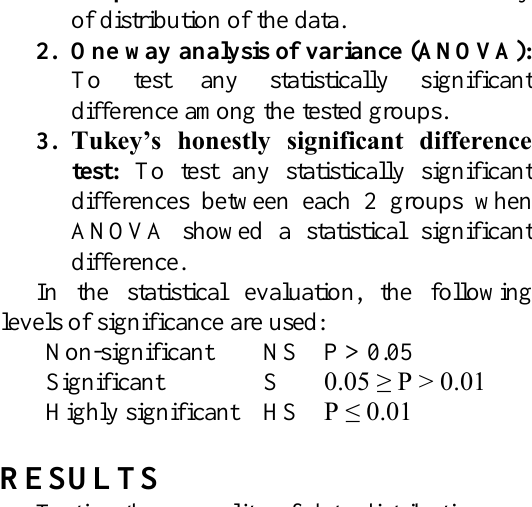
Table 3: Descriptive statistics of the tensile